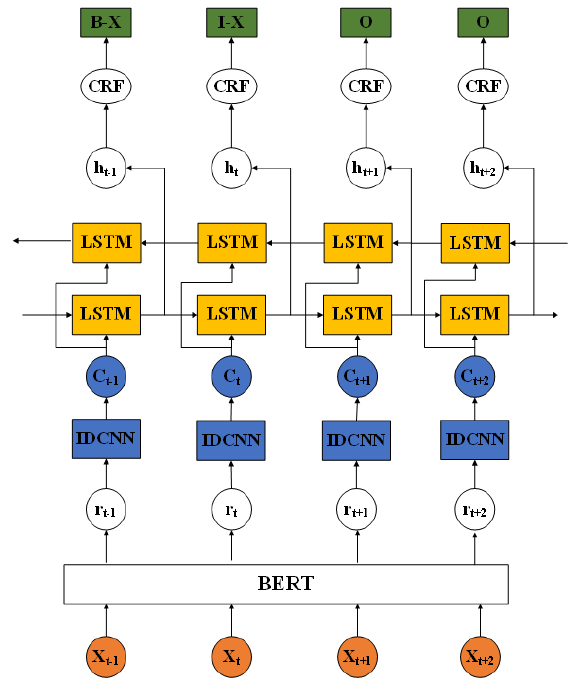
Figure 1. BIBC model structure